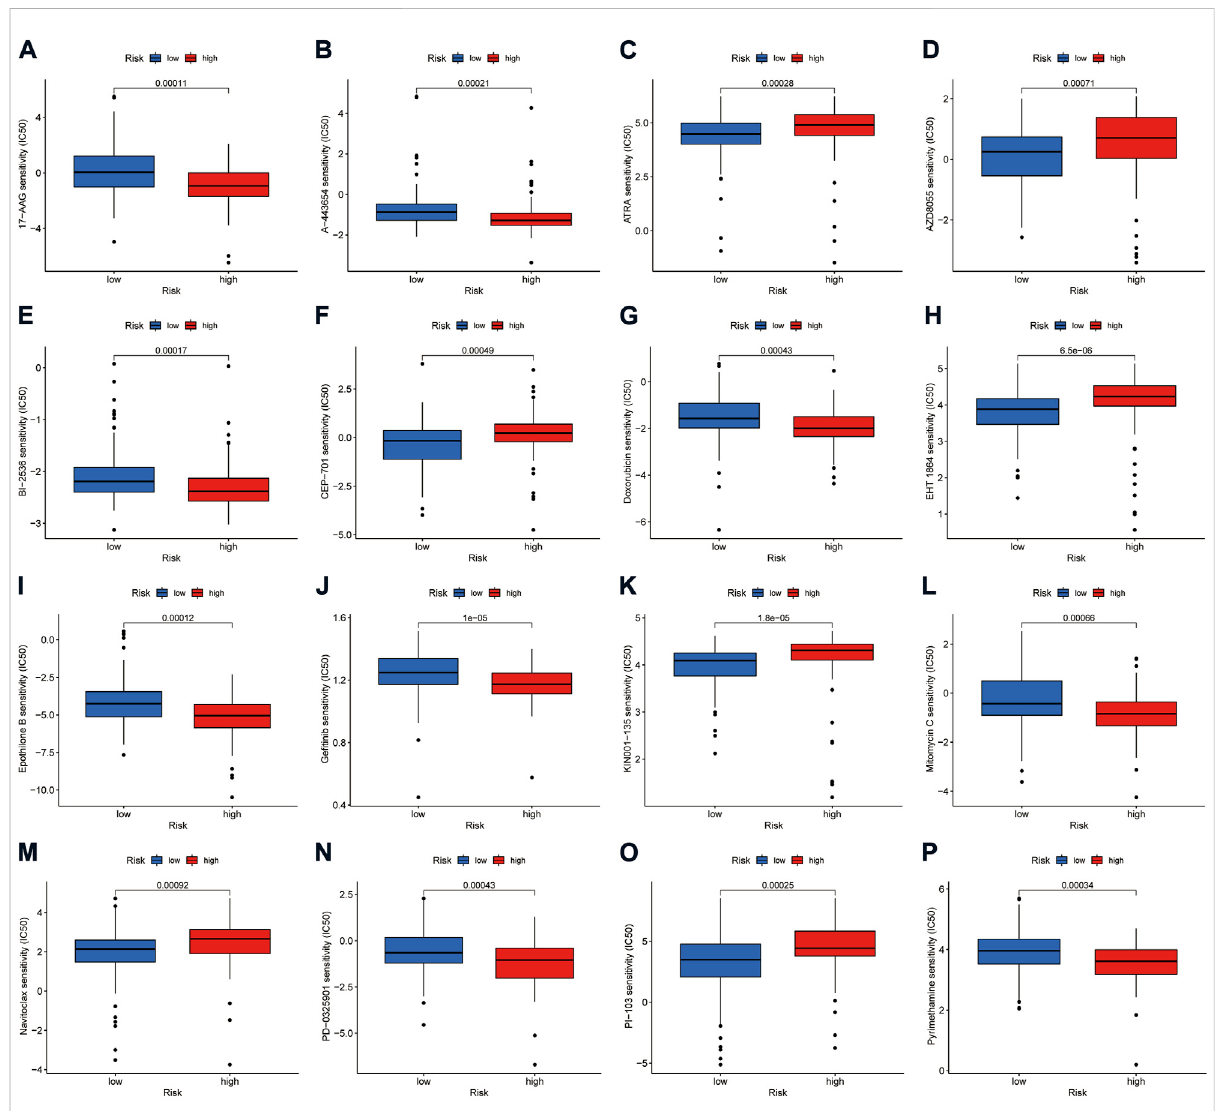
FIGURE 9 Investigation of drug sensitivity in risk groups. (A – P) Comparison of IC50 values for different agents in high- and low-risk